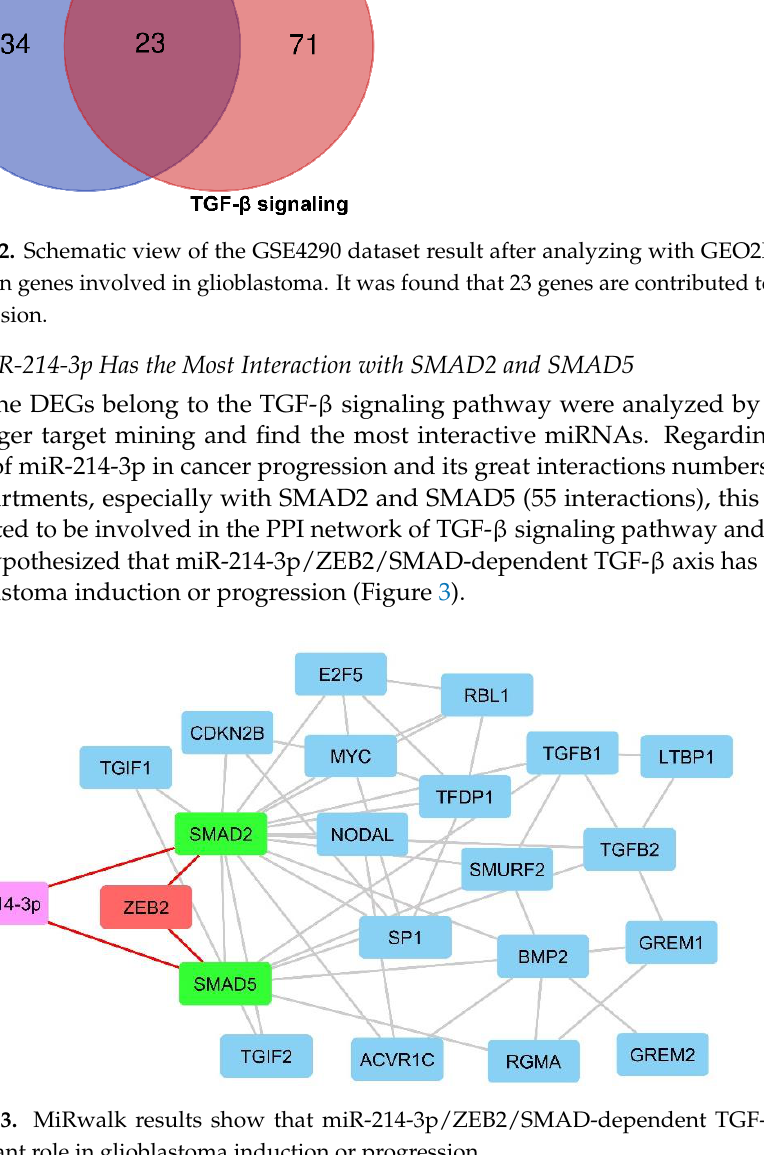
Figure 3. MiRwalk results show that miR-214-3p/ZEB2/SMAD-dependent TGF- β axis has an im- portant role in glioblastoma induction or progression.